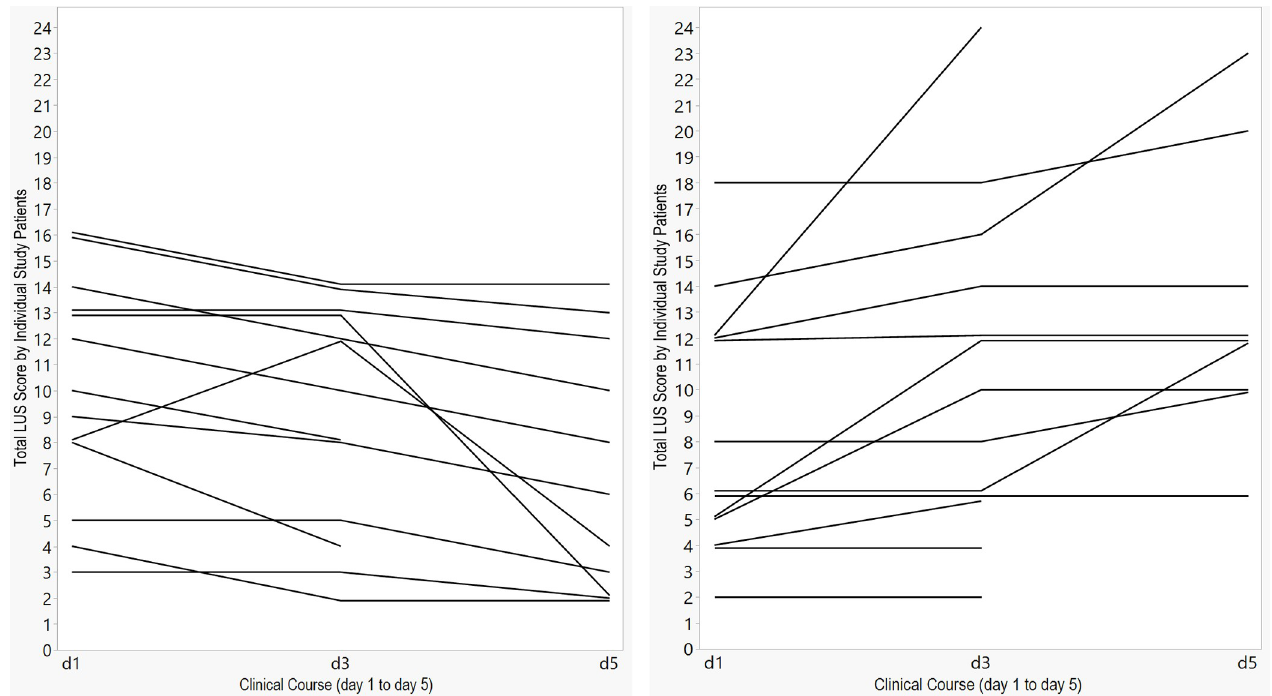
Fig 4. Patients with decrease of cumulative B-lines (total LUS score) on the left side (n = 13) and increase (n = 9) or stable results (n = 4) on the right side (last LUS-baseline LUS).